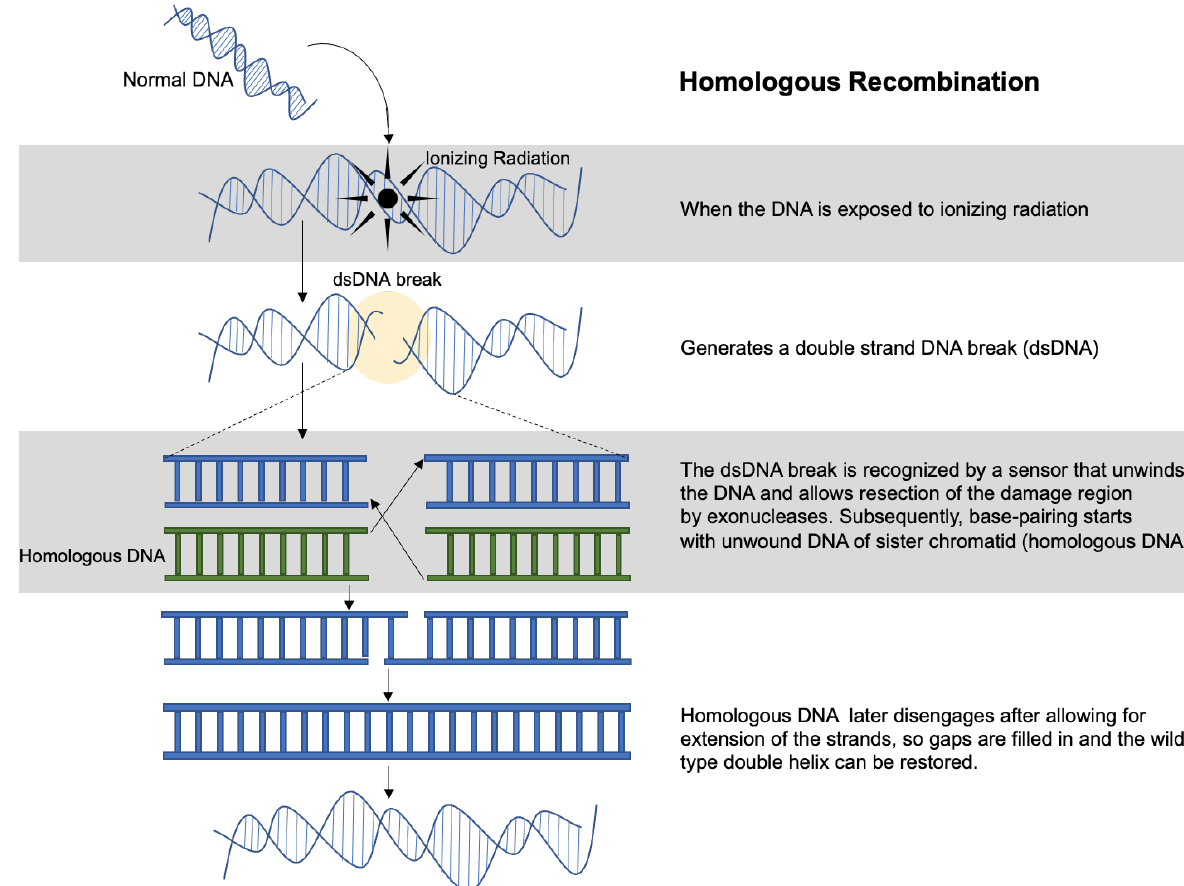
Figure 1. Diagram of homologous recombination after ionizing radiation. Ionizing radiation can initiate double-stranded DNA (dsDNA) breaks that can be repaired through homologous recombination — a process in which the cell utilizes a homologous DNA strand as a template for DNA repair.